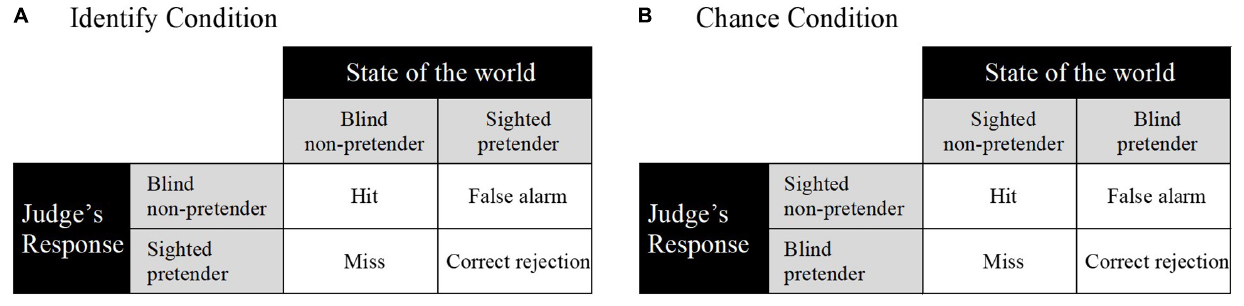
FIGURE 2 | Modified imitation game and signal detection matrices for the Identify condition (A) and the Chance condition (B) . Hit: correctly indicating a signal is present; false alarm: incorrectly indicating that a signal is present; miss: incorrectly indicating that no signal is present; correct rejection: correctly indicating that no signal is